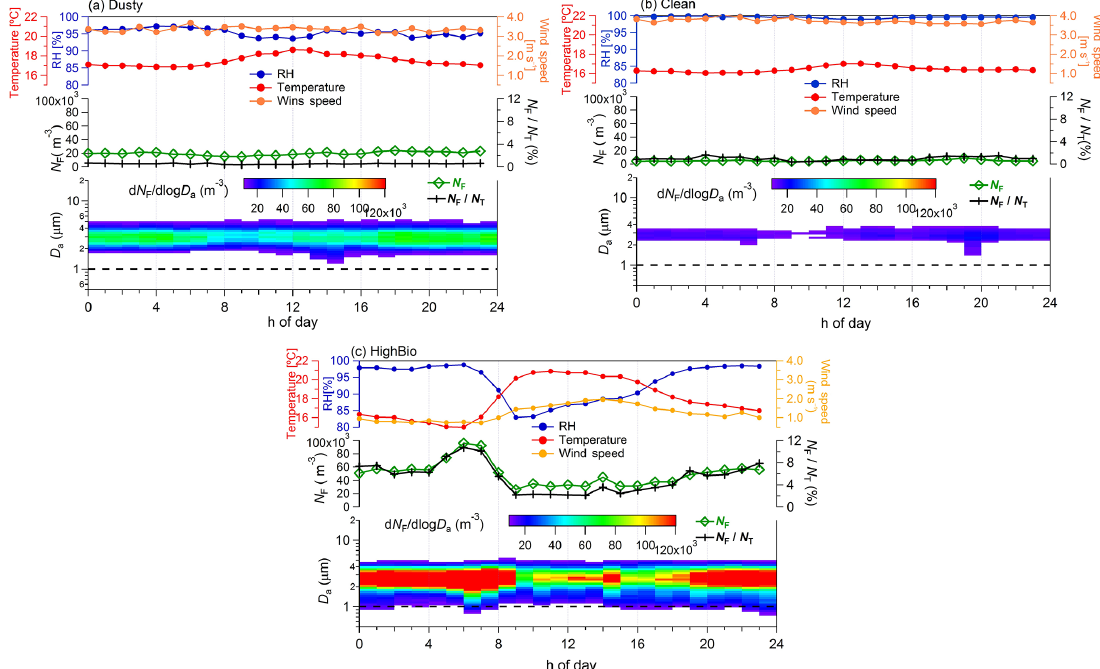
Figure 10. Diurnal cycles of observed meteorological parameters, FBAP number concentrations ( N F ) and size distributions averaged over each distinct focus period identified during measurements carried out at Munnar (hourly mean values plotted against the local time of day). The upper portion of each panel shows the observed meteorological parameters: relative humidity (%; blue), temperature ( ◦ C; red), and wind speed (ms − 1 ; orange on the right axis). The middle panel shows the integrated FBAP number concentration ( ∼ 1–20µm; N F ) on the left axis (green) and the FBAP fraction of the TAP number ( N F /N T ) on the right axis (black). The lower portion of each panel FBAP number size distribution (3-D plot) plotted against the hour of the day on the x axis, aerodynamic diameter on the y axis, and color, is scaled for D N F / dlog D a and indicates the concentration. Dashed black lines in the lower portion of each panel at 1.0µm show the particle size cutoff diameter below which fluorescent particles were not considered to be FBAPs due to potential interference with non-biological aerosol particles. (a) Dusty, (b) clean, and (c) high bio. Please refer to the figures in the Supplement for corresponding TAP